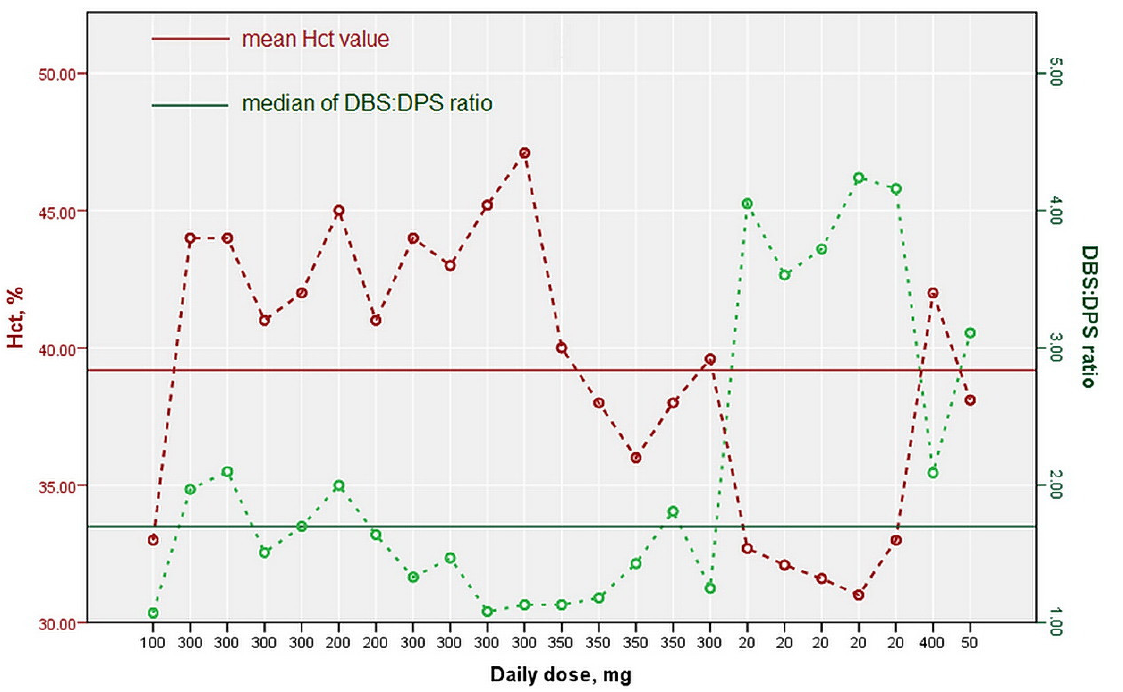
Figure 4. Diagram of ZNS erythrocyte to plasma ratio regarding the Hct % and daily dose of ZNS.